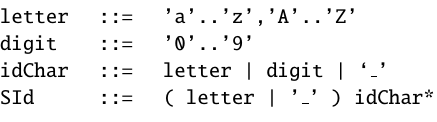
Figure 2.2: The definition of the type